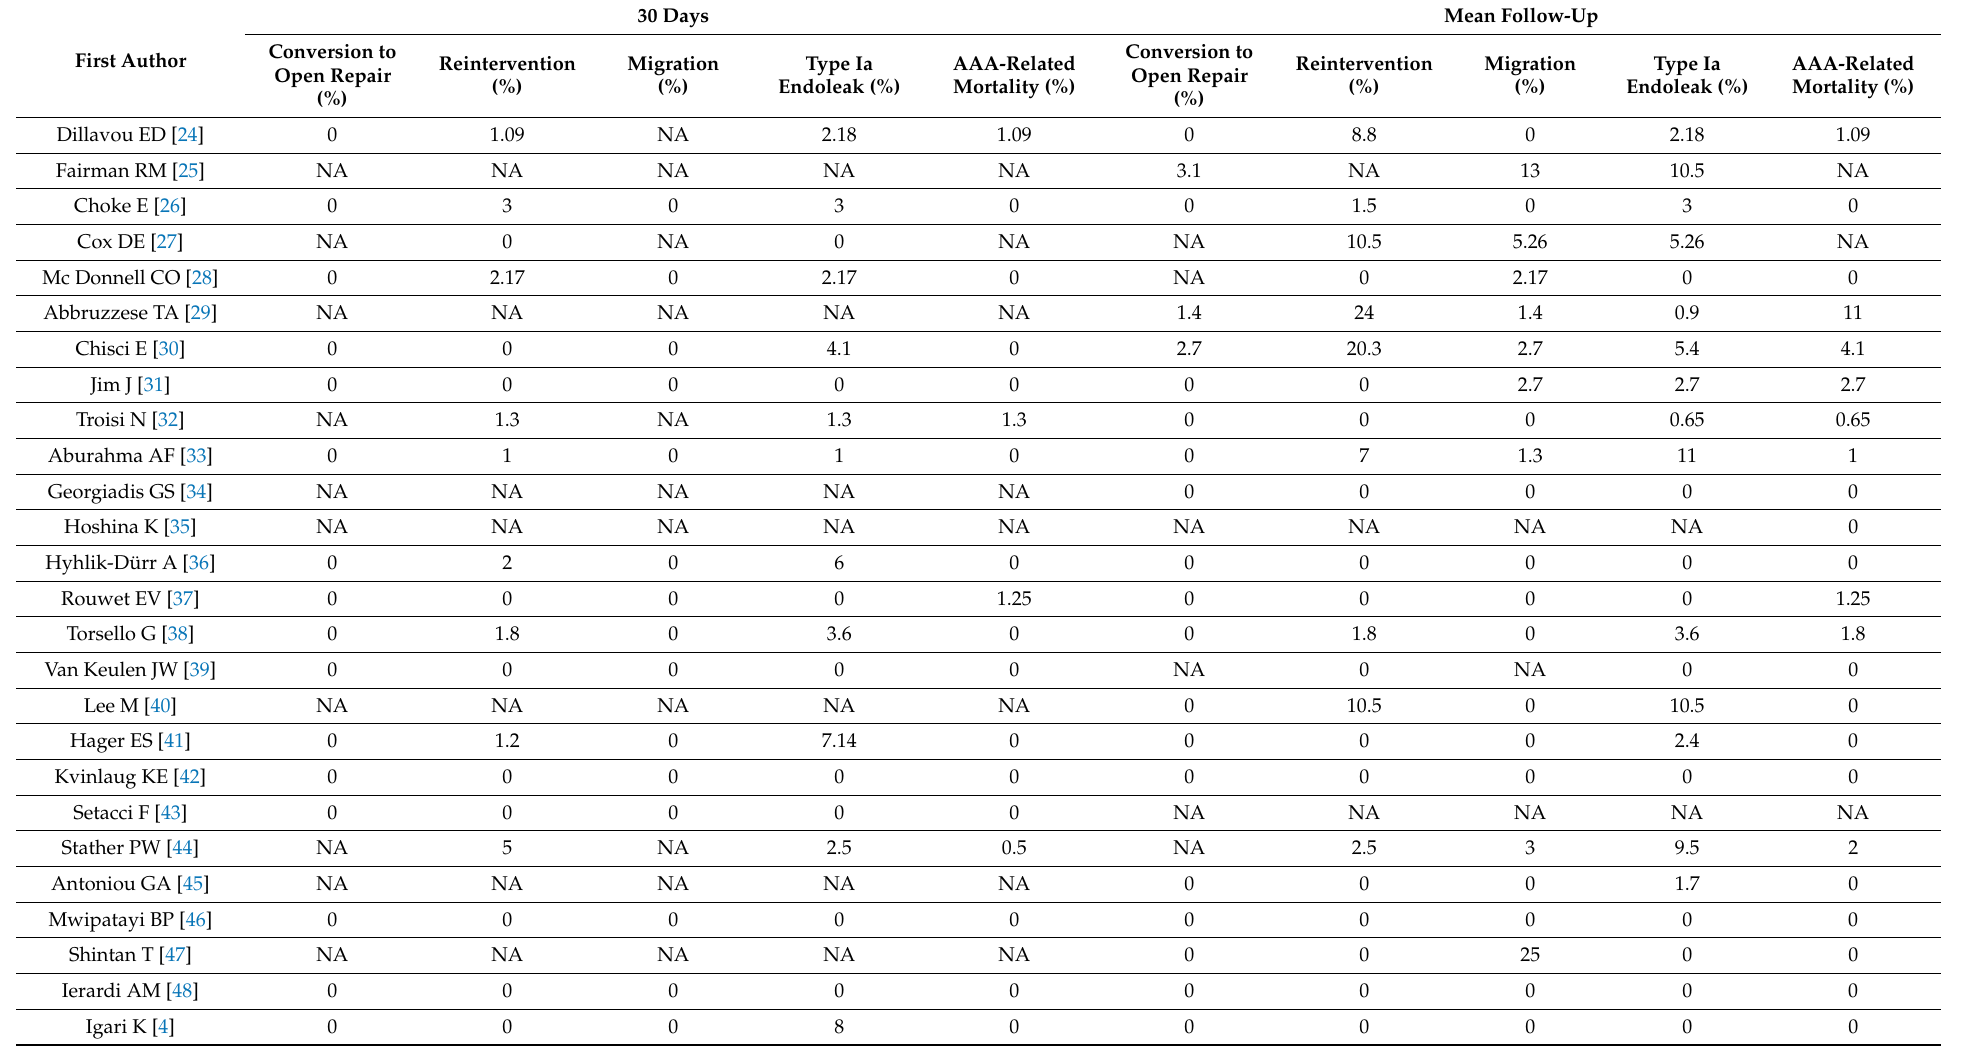
Table 2. Thirty-day, and mean follow-up complications rates of the 52 studies selected for the